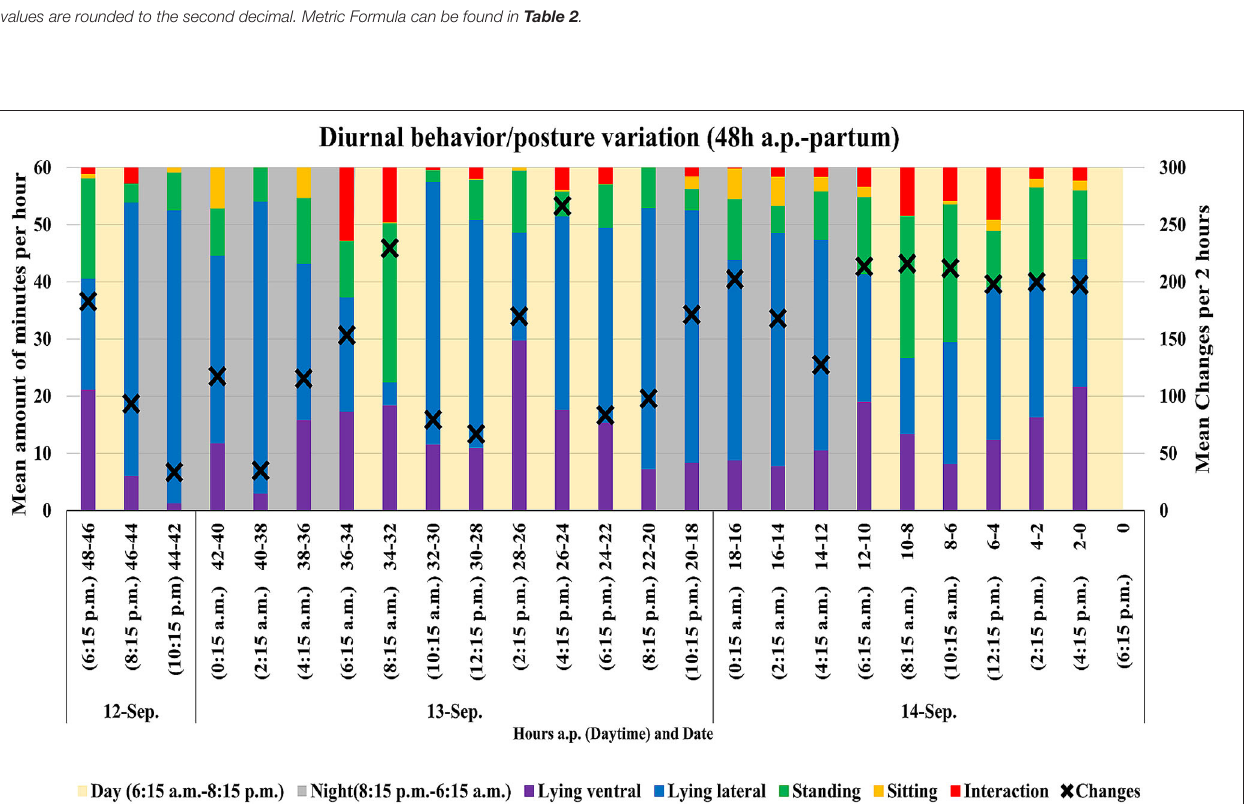
FIGURE 6 | Demonstration of the varying amount (in min per hour) of behavior/posture (lying ventral, lying lateral, standing, sitting and interaction) in mean for 2h intervals. The black crosses indicate the mean total amount of behavior/posture changes per 2h. The yellow and gray colors between the intervals indicate day and night. One frame per second was analyzed. Note that zero indicates the birth of first